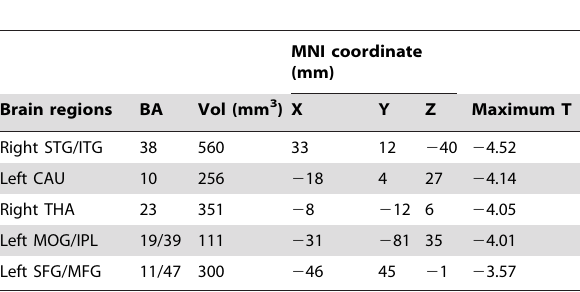
Table 2. Regions showing GM volume atrophy in the svMCI